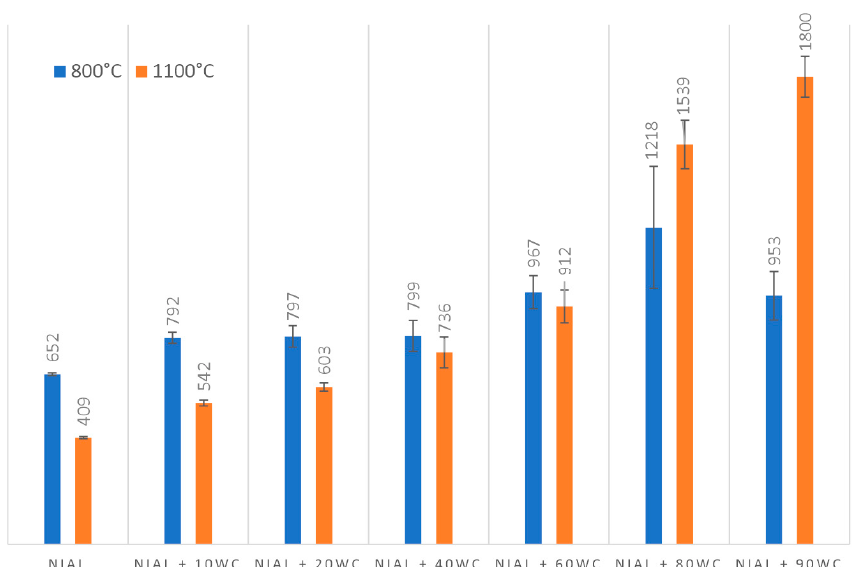
Figure 11. Vickers hardness of NiAl-xWC composites sintered at 800 °C and 1100 °C.